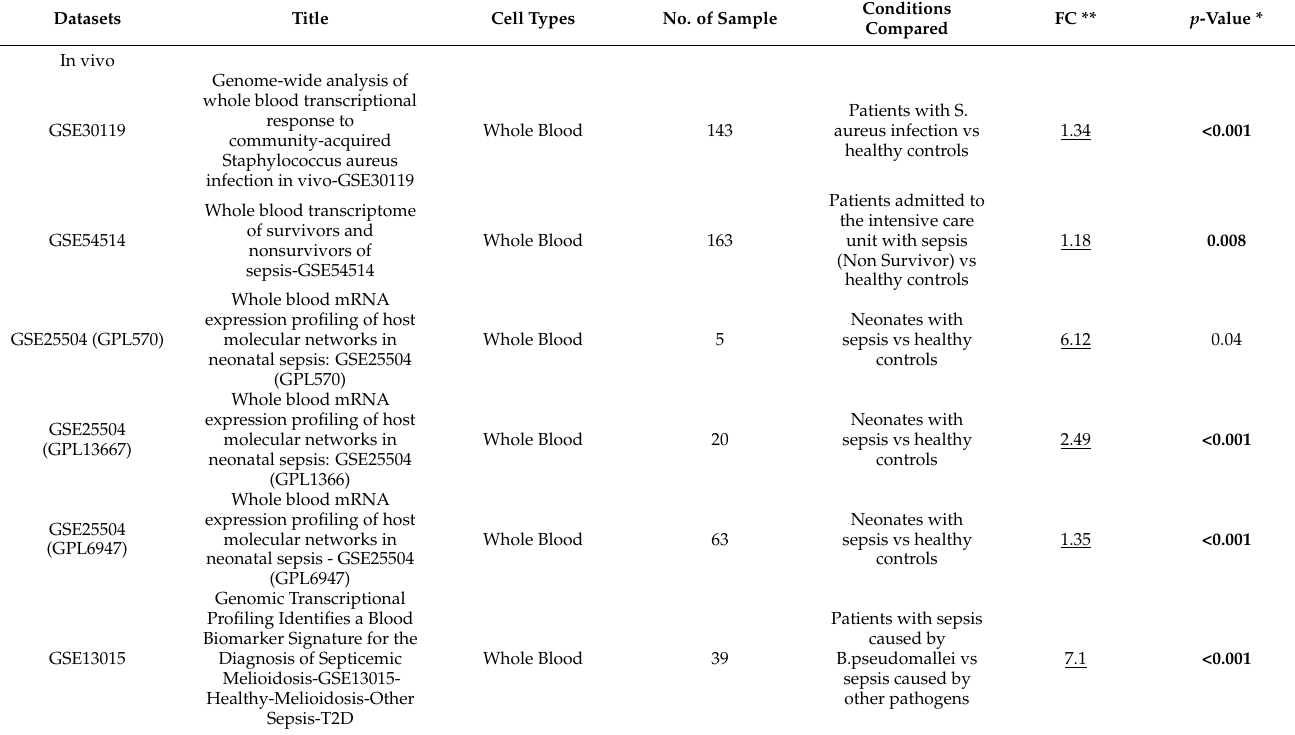
Table 1. Changes in ERLIN1 gene expression during sepsis in additional relevant datasets. The table includes the GEO ID number for each dataset (GSE), as well as the title of the dataset as recorded on the GEO database. In addition, we report for each dataset the cell types employed, the total number of samples, the conditions compared, the fold change (FC) observed with hyperlinks to the SysInflam HuDB page (for instant visualization), and the p -value calculated for the reported